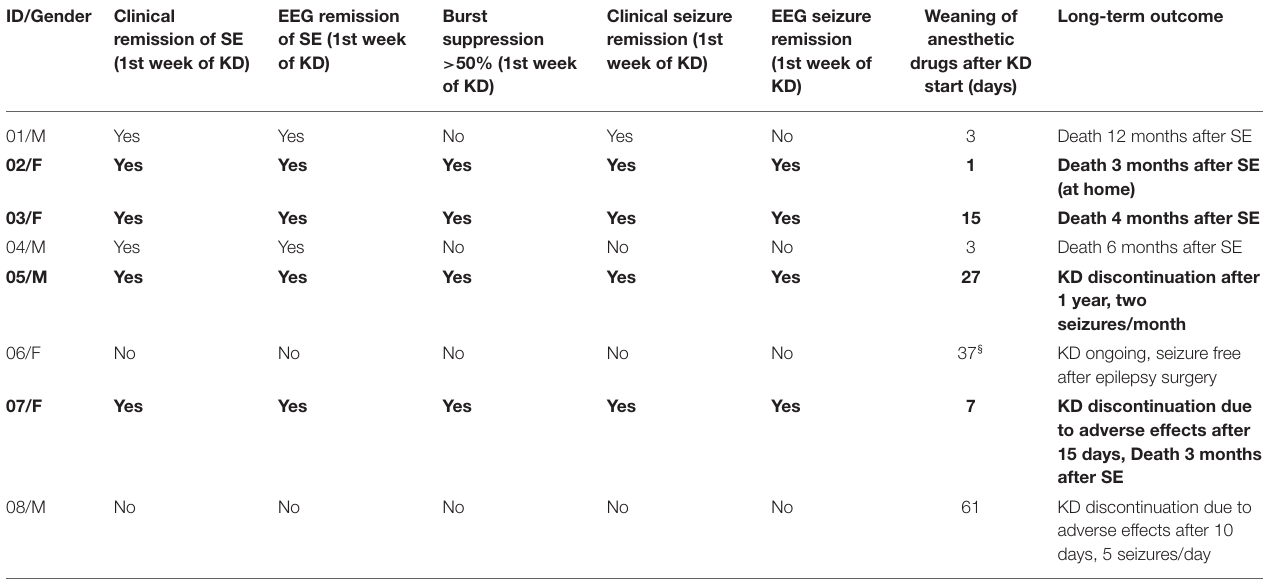
TABLE 3 | Effectiveness on seizures and EEG and long-term outcome. ID/Gender Clinical remission of SE